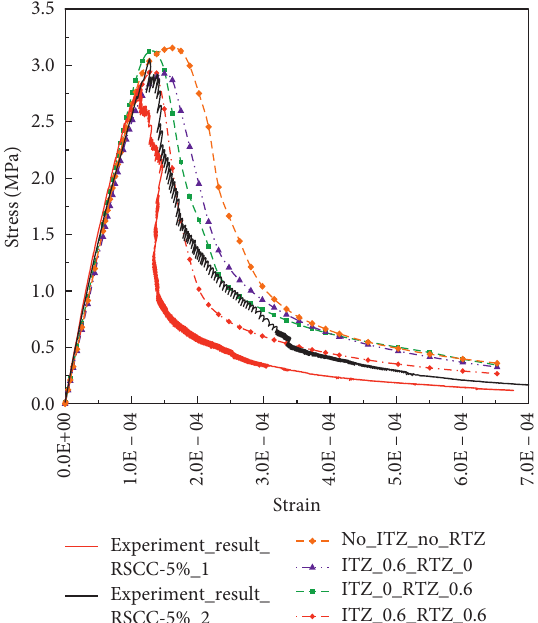
Figure 8: Stress-strain curves of the A-M ITZs and R-M ITZs existence study.